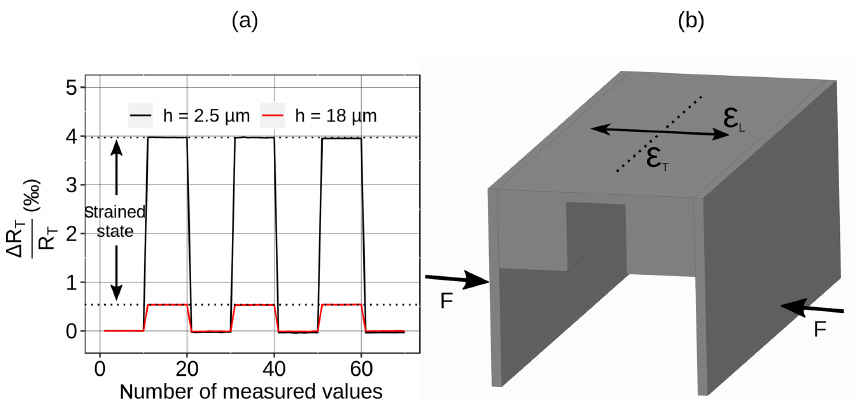
Figure 6. (a) Relative resistance change in transversely applied SGs ( w = 50µm) depending on the path height ( h = 2 . 5 and 18µm). Three load cycles with a strain (cid:15) L of 1‰ were performed. (b) The device, according to VDI/VDE standard 2635, used to characterize the transverse sensitivity of SGs.